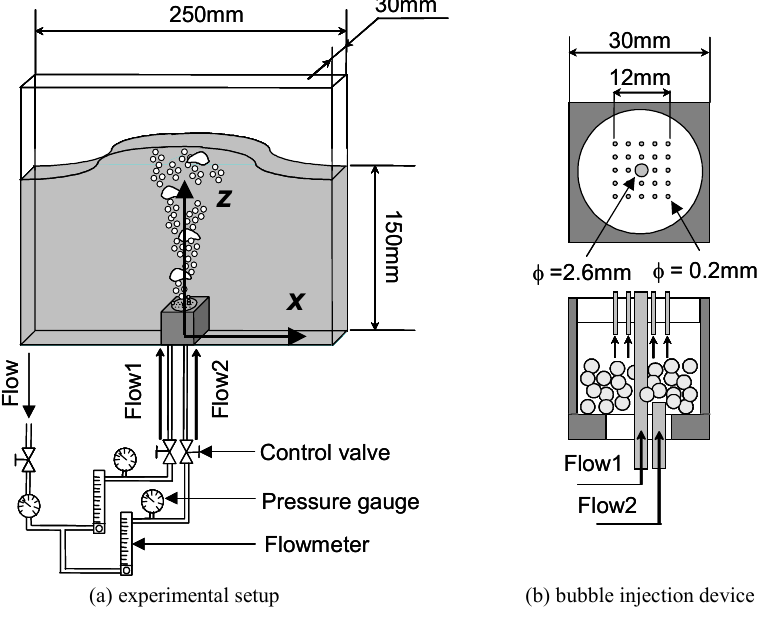
Fig. 2 Experimental setup and bubble injection